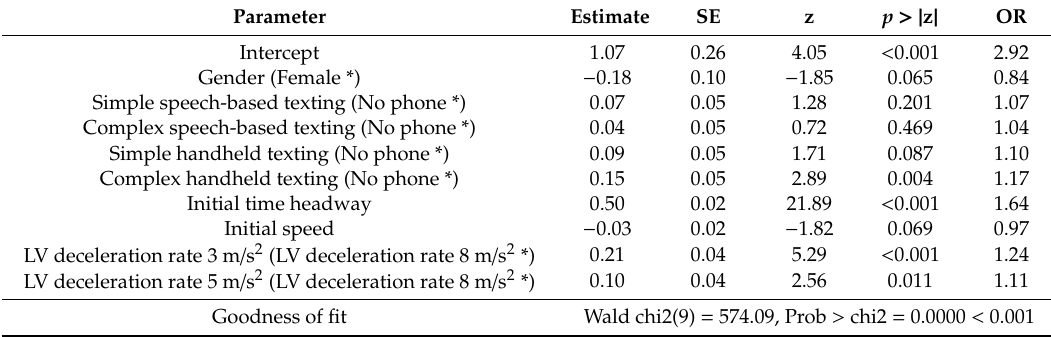
Table 2. Results of the generalized linear mixed model for the brake reaction